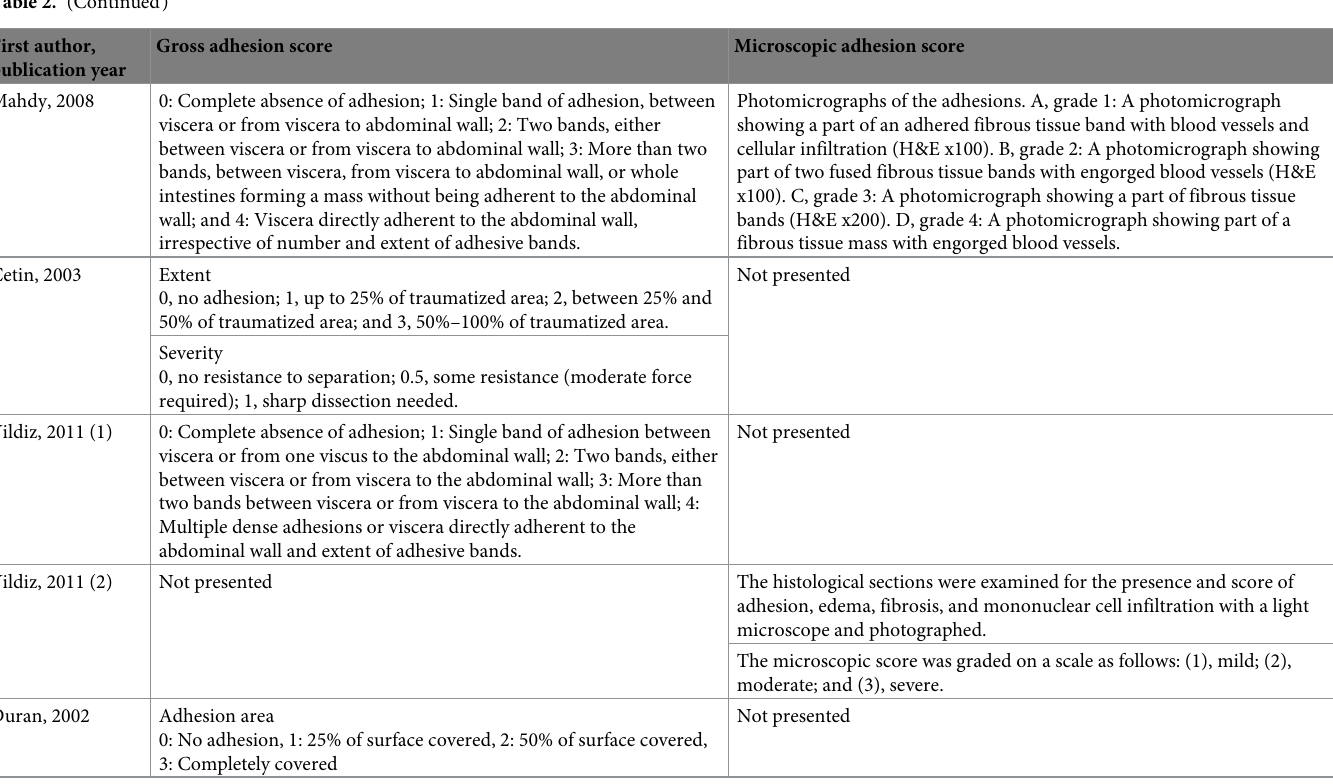
Photomicrographs of the adhesions. A, grade 1: A photomicrograph showing a part of an adhered fibrous tissue band with blood vessels